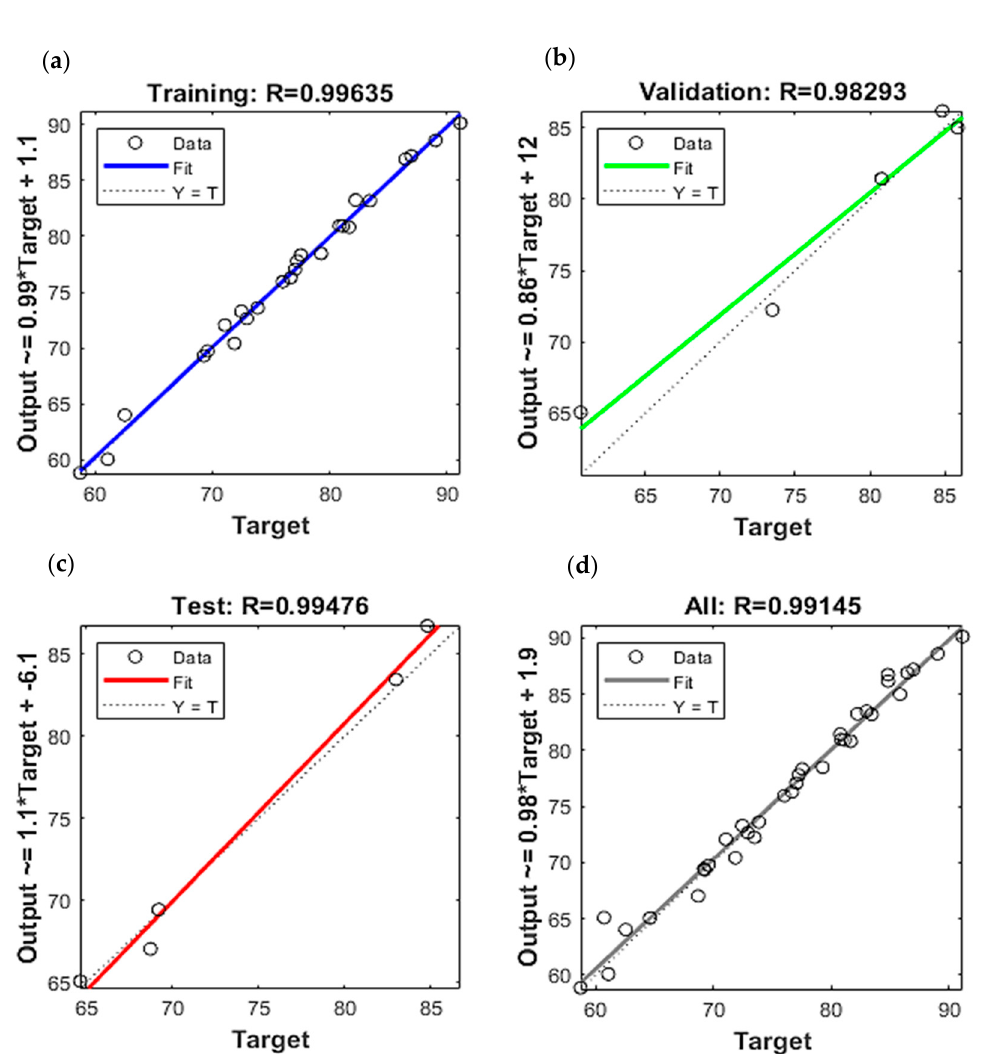
Figure 10. Comparison of predicted and observed WQI values during ( a ) training, ( b ) validation, and ( c ) testing phases ( d ) all during the wet season.